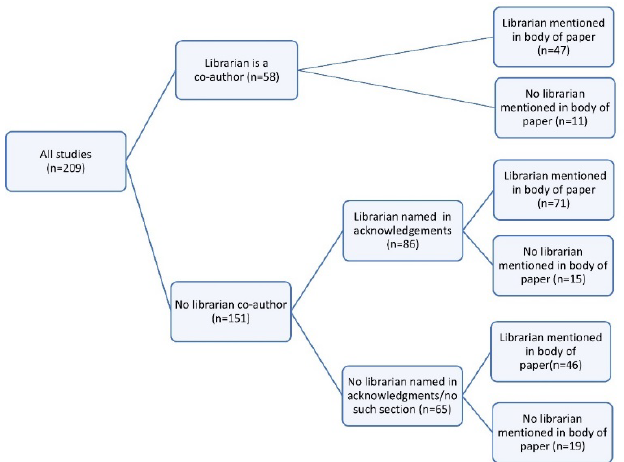
Figure 2 Breakdown of documentation of librarian